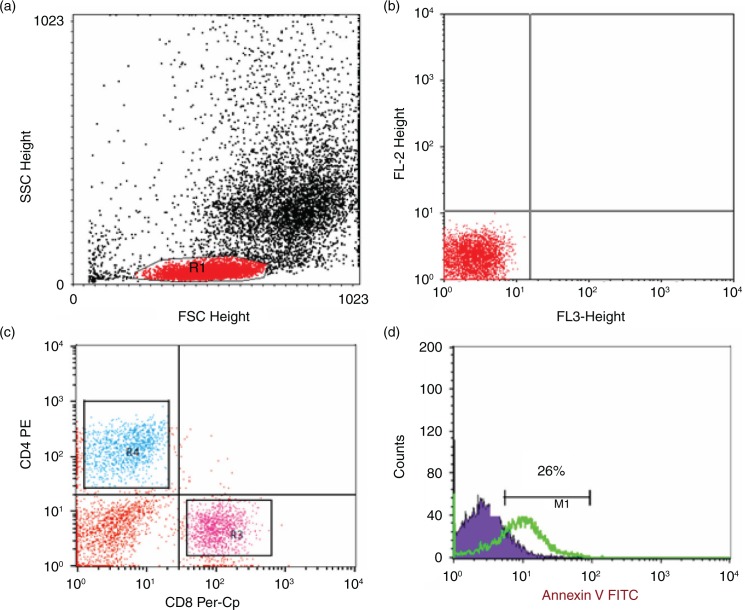
Flow cytometric analysis of T lymphocytes apoptosis. (a) Forward and side scatter histogram was used to define the lymphocytes. (b, c) The expression of CD8 and CD4 was assessed in lymphocytes population compared with the negative isotype control. The T-helper cells (CD4+) and T cytotoxic cells (CD8+) were gated for further analysis of annexin V expression. (d) Example of annexin V expression on T cells (CD4+ or CD8). The positivity was defined as fluorescence (green histogram) higher than that of the isotype control (blue histogram).